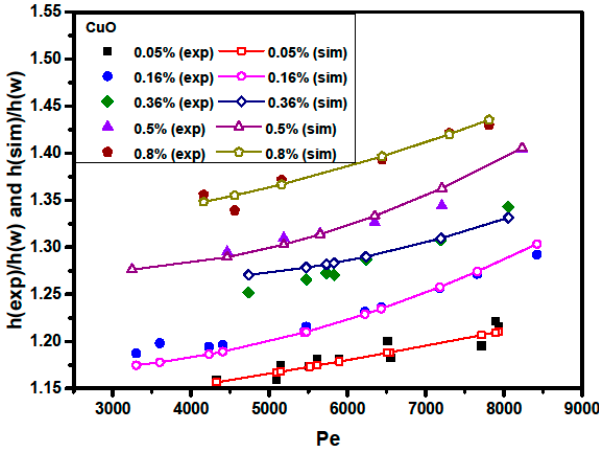
Figure 13. Comparison between numerically-predicted and experimentally-measured heat transfer coefficients at various particle volume concentrations and Pe values for CuO/water nanofluids.